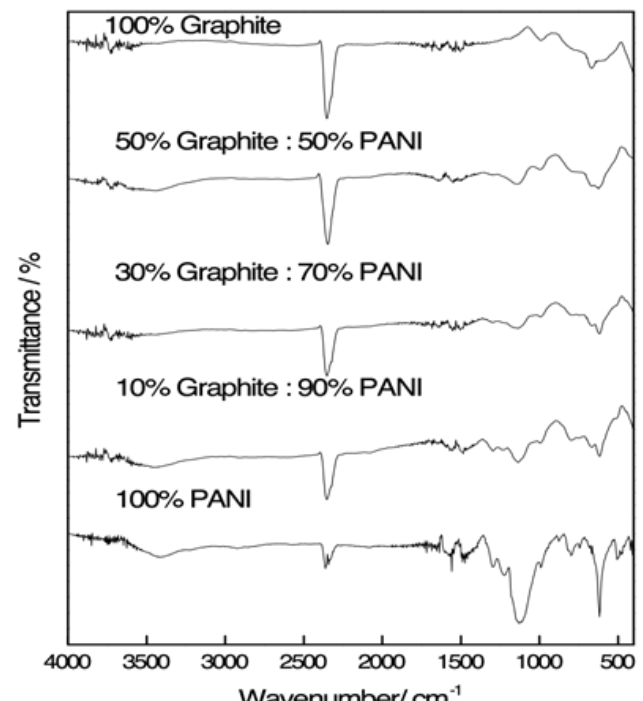
Figure 4: FT-IR spectra of different ratios of SLVG/PANI composites.